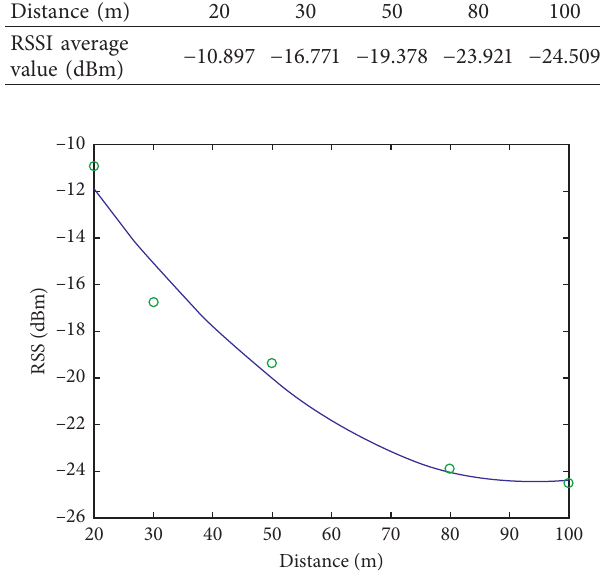
Figure 1: Echoism between RSSI and Table 2: The values of λ and ξ Environmental